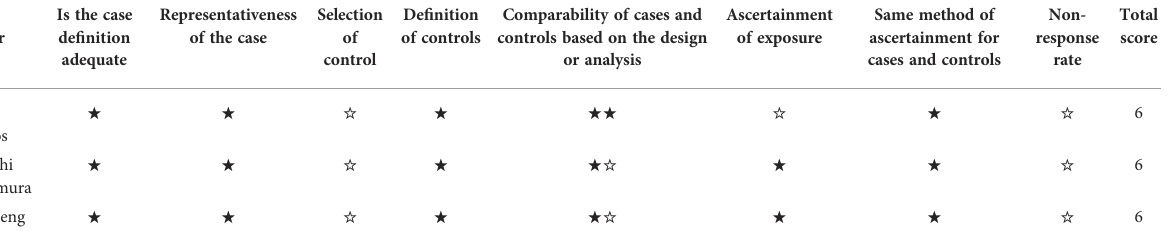
TABLE 3 Assessment of risk of bias and applicability concern for all included case-control studies.